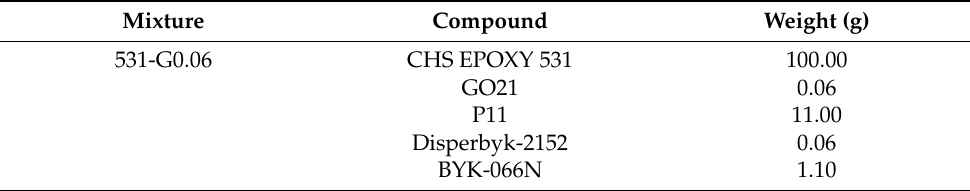
Table A12. Graphene oxide GO21 CHS Epoxy 531, 0.06 phr.